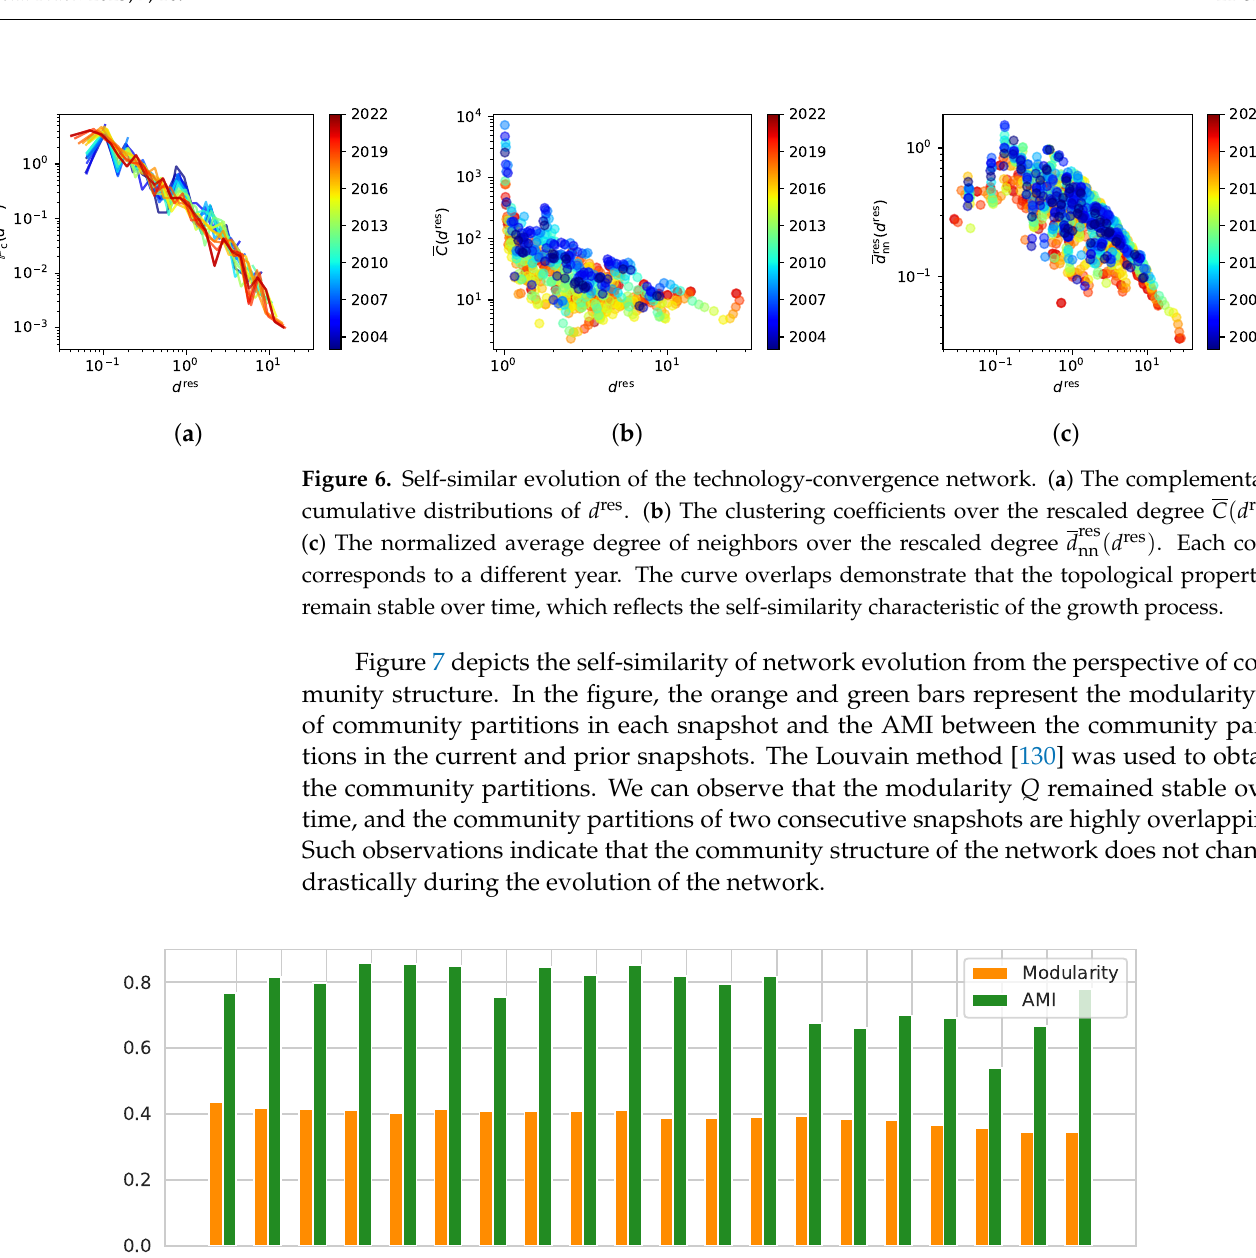
Figure 7. Consistency of the community structure during the evolution of the technology-convergence network. It can be observed that the modularity remains stable and the AMI between two consecutive snapshots is relatively high, which matches with the characteristic of self-similar growth: that the community structure of the network remains